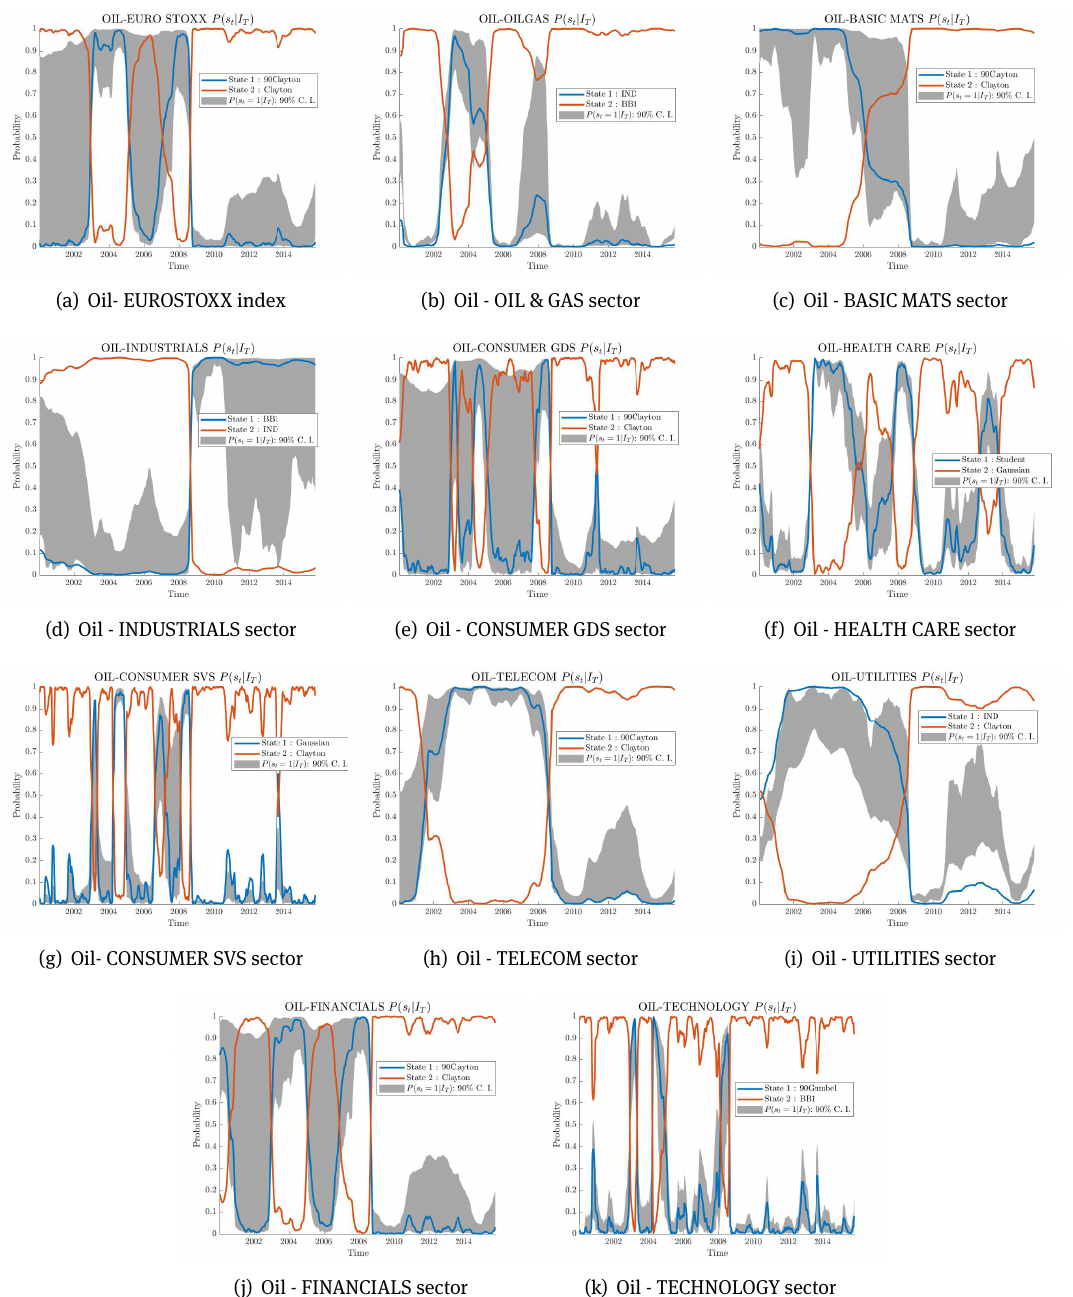
Figure 6a: Smoothed probabilities assuming different copula type across